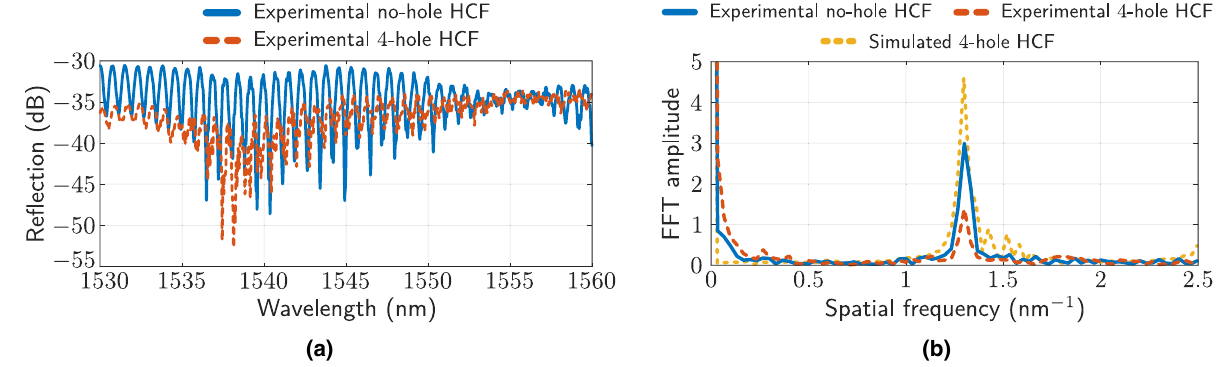
Figure 6. ( a ) Reflection spectra of the no-hole HCF (Fig. 2), and the 4-hole HCF (Fig. 3b). ( b ) FFT amplitude from the spectra of ( a ), as well as the one corresponding to the simulated structure.